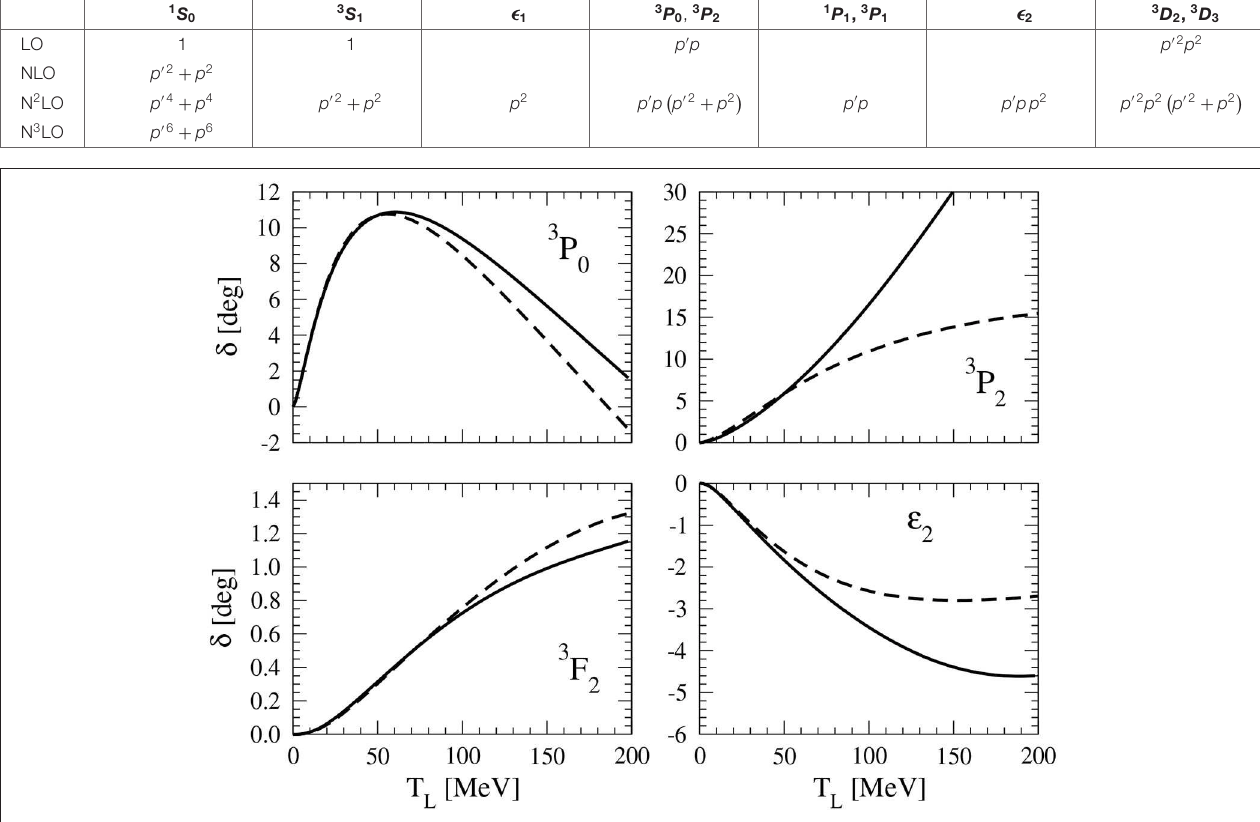
FIGURE 5 | Two-nucleon 3 P 0 and 3 P 2 - 3 F 2 phase shifts ( δ ) and mixing angle ( ε 2 ) as functions of the laboratory energy T L . The LO results (solid lines) at a cutoff 3 3.94 GeV are compared with the Nijmegen PWA [84] (dashed lines). Reprinted figure with permission from reference [20]. Copyright (2005) by the American = Physical